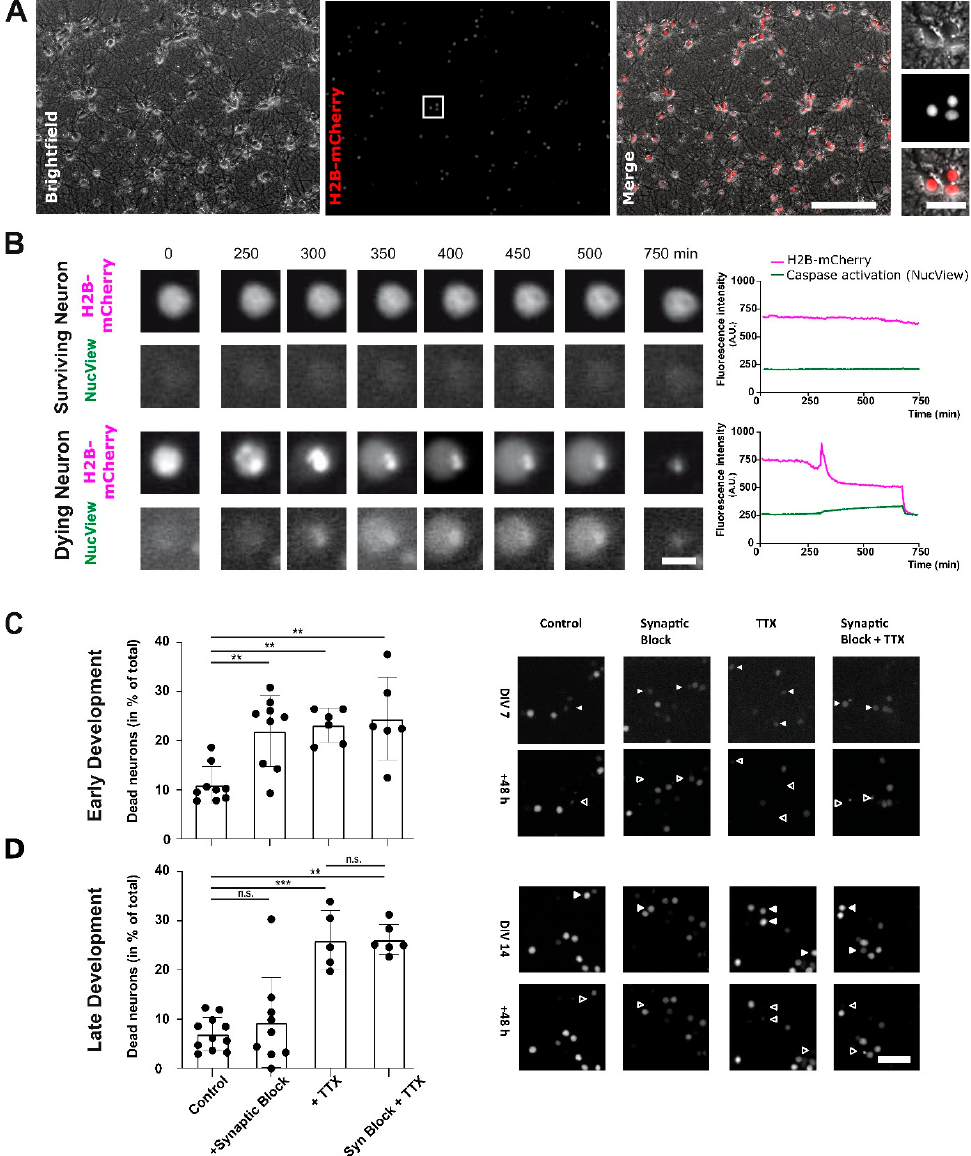
Figure 1. Live cell imaging of H2B-mCherry labeled primary cortical neurons can be used to quantify neuronal survival throughout development and upon pharmacological modulation of neuronal activity. ( A ) Representative primary cortical culture with nuclear fluorescence labeling using a transgenic mCherry-tagged histone cluster protein (H2B-mCherry) at DIV16. ( B ) Nuclear H2B-mCherry signal (magenta) enables the identification of hallmarks of apoptosis: chromatin condensation and DNA fragmentation. Longitudinal imaging of H2B-mCherry positive nuclei in cortical cultures shows constant signal intensity and appearance in surviving neurons without a relevant change in NucView signal (green). In contrast, dying neurons can be clearly identified by a change in H2B-mCherry signal appearance (nuclear fragmentation, swelling and condensation) followed by a strong decline in signal intensity or its disappearance. ( C ) Survival rates in primary cortical neurons in the early developmental period (DIV7-9) are significantly diminished upon pharmacological blockade of synaptic transmission (10 µ M CNQX, 50 µ M d-APV, 10 µ M Gbz; n = 9/9; p < 0.01), of action potential generation (1 µ M TTX; n = 6; p < 0.01) or after blockade of both processes ( n = 6; p < 0.01). In the representative images, full arrowheads point to healthy H2B-mCherry positive nuclei at the start of the experiment and the unfilled arrowheads mark its former location after cells died. ( D ) In the late developmental period (DIV14-16), neuronal survival rates are no longer diminished by the blockade of synaptic transmission ( n = 11/11; p < 0.05), but still, more neurons die during the blockade of neuronal firing ( n = 9; p < 0.001). Scale bars represent 100 µ m ( A , C , D ), 20 µ m (insert ( A )), and 10 µ m ( B ). Data points indicate the mean ± SEM. **, *** indicate p -values of 0.01, and 0.001,